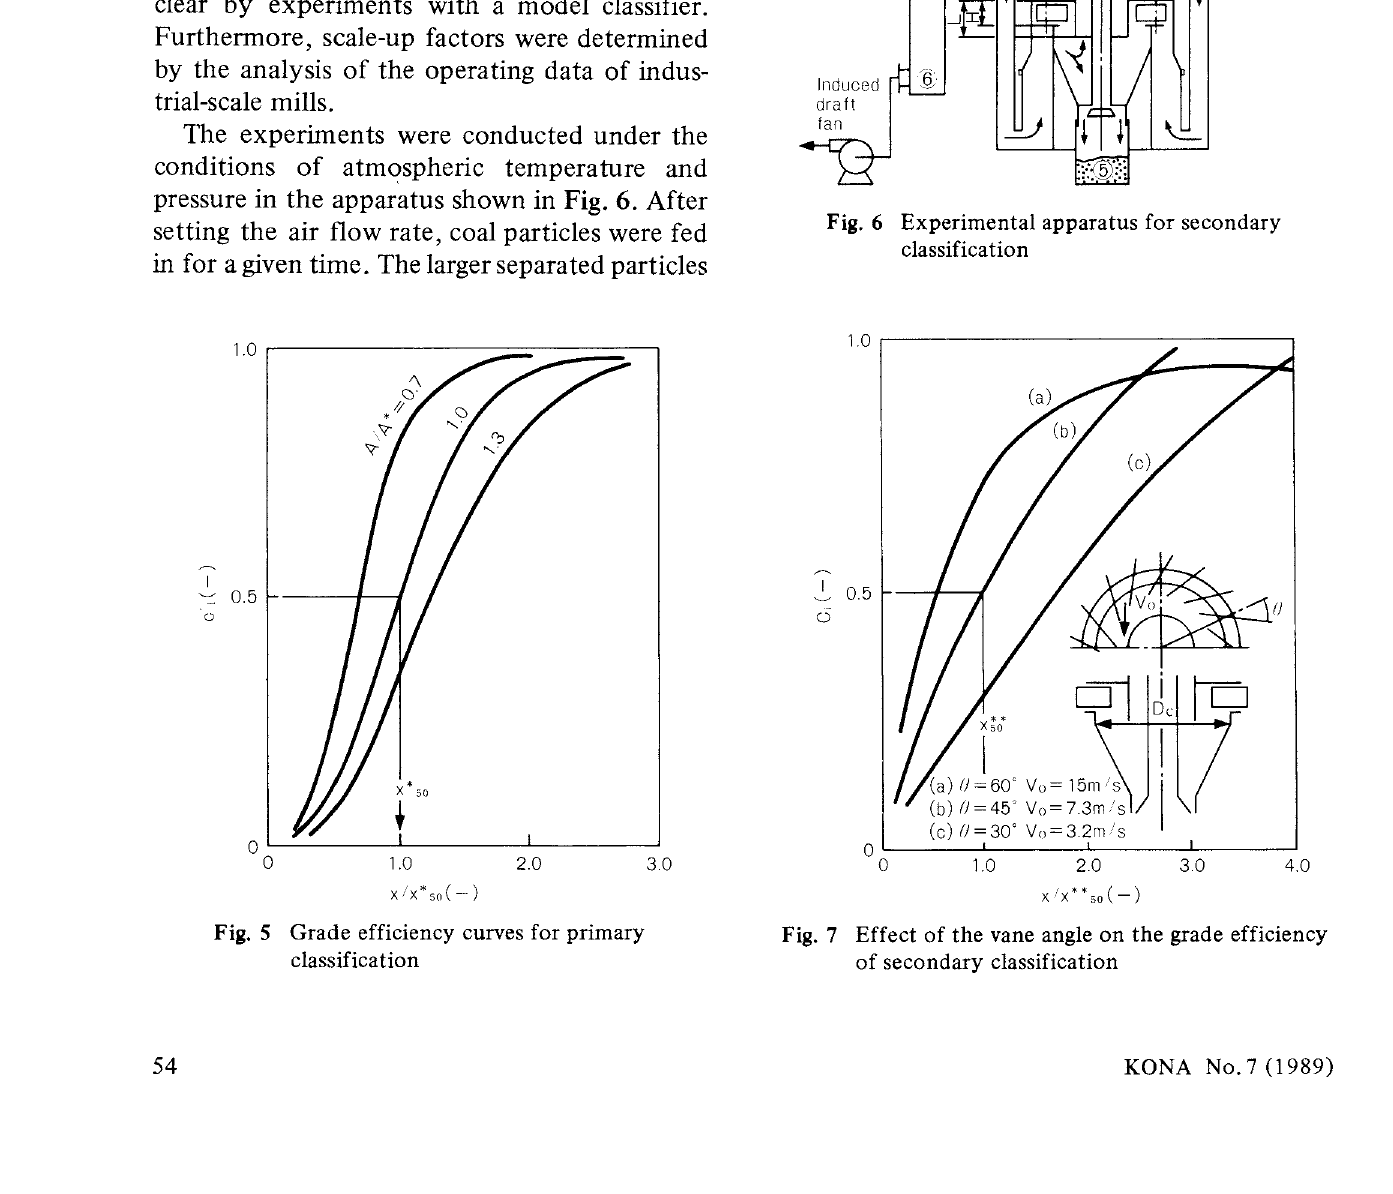
Fig. 6 Experimental apparatus for secondary